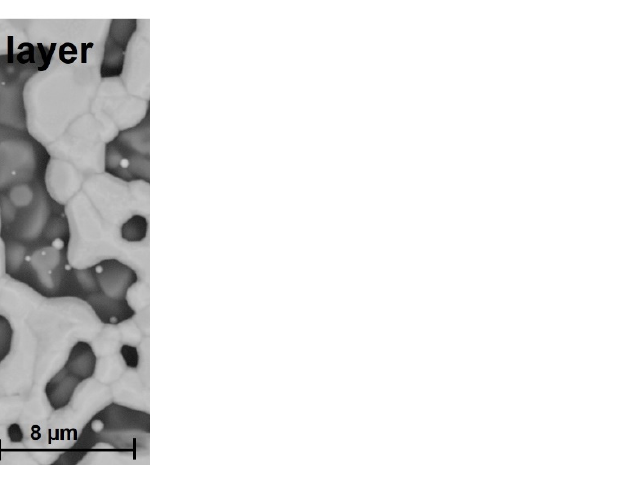
Figure 4. SEM image of the copper–nickel film—CuNi 55:45 ink, 1 layer, 1 firing—1: CuNi film, 2: Al 2 O 3 substrate.